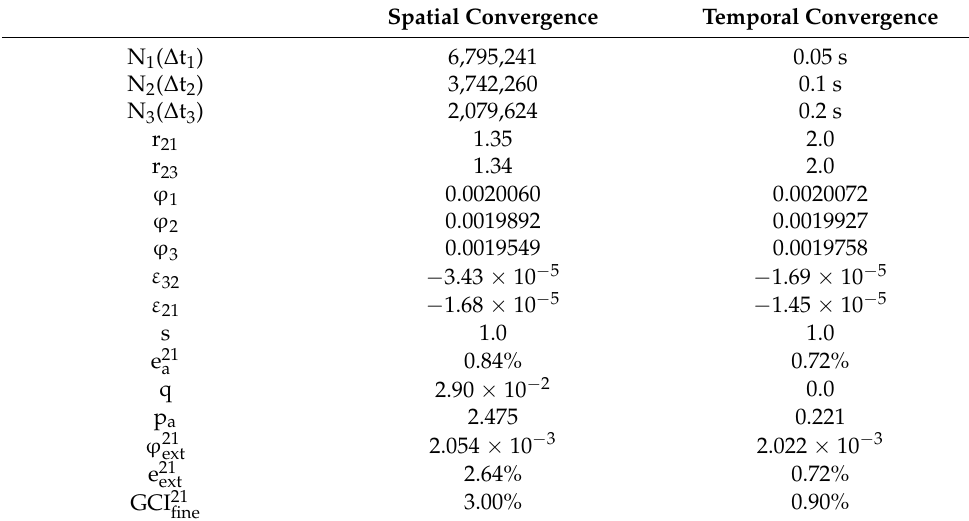
Table 4. Calculation of the discretization error for the verification study.